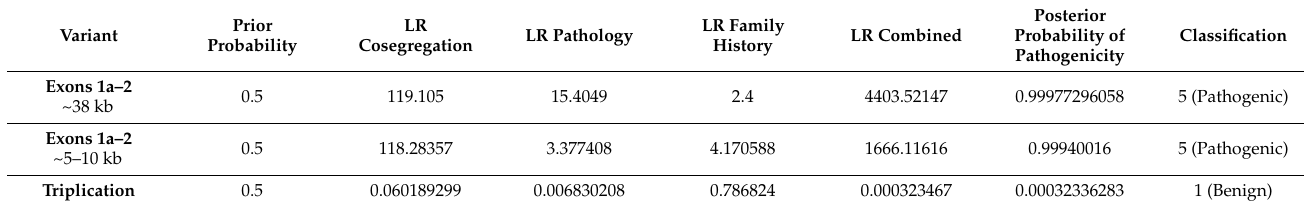
Table 4. Classification of LGR affecting the 5 (cid:48) region of BRCA1 and exons 1 and